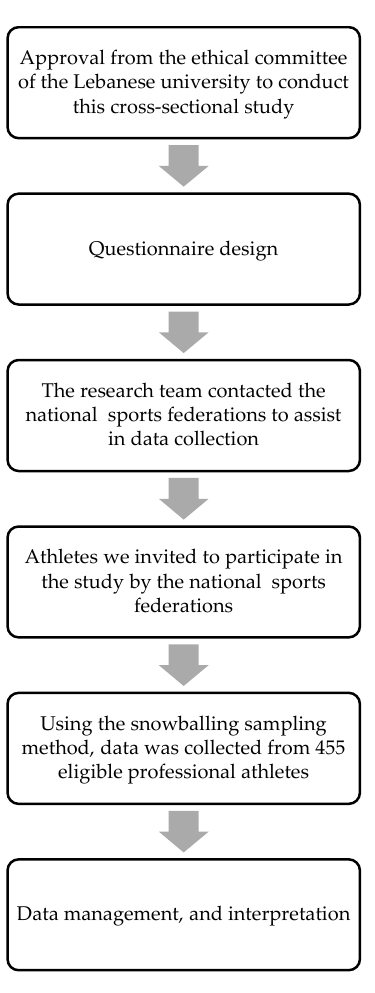
Figure 1. Flowchart of study design.